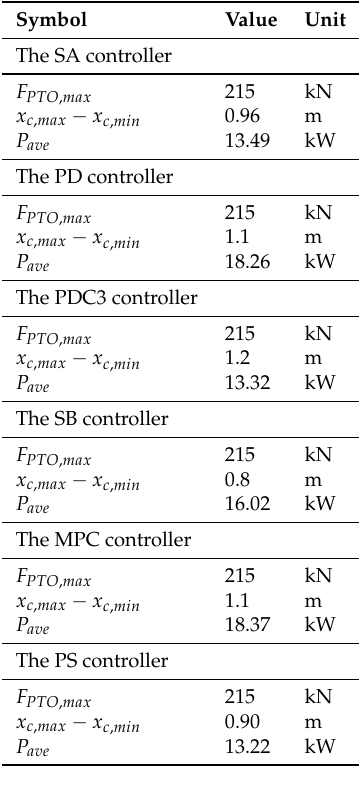
Table 4. Capacity requirement of the controllers with hydraulic